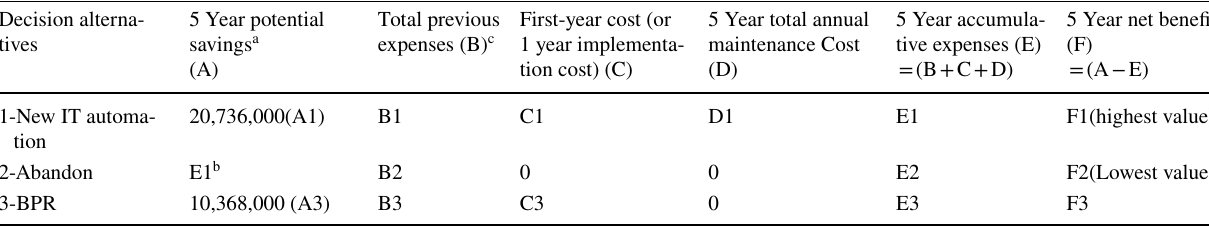
Table 4 Estimated costs and benefits (CB) for five years